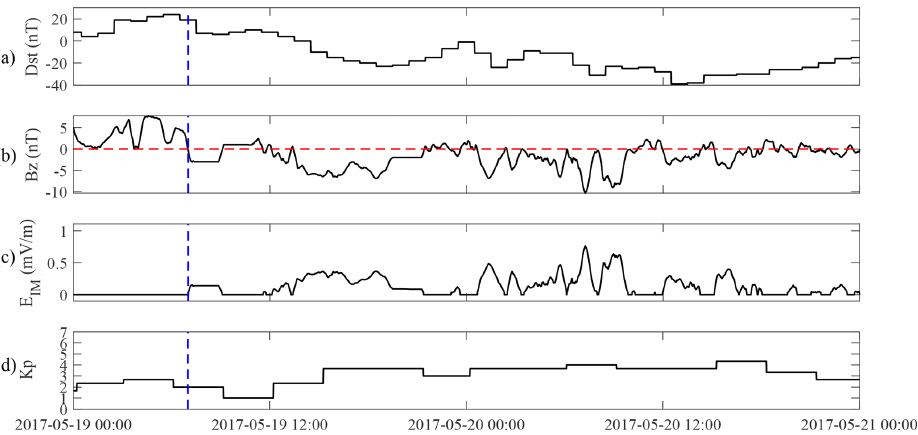
Figure 7. The indices of geomagnetic activity and solar wind during the geomagnetic storm that occurred in the time interval of 19– 20 May 2017: (a) Dst index, (b) B Z index in GSM coordinates. The dotted red line indicates the position where B Z is equal to 0, (c) E IM index, and (d) Kp index. The start time of the geomagnetic storm (07:02UT on 19 May 2017) is marked by the vertical dashed blue line.